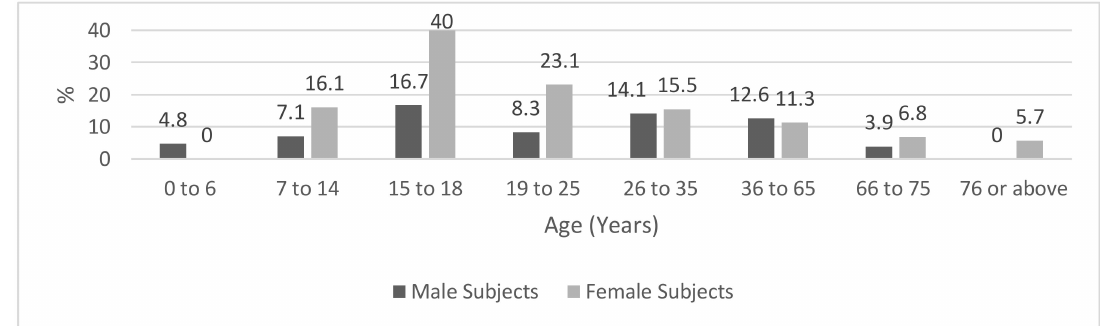
Figure 3. Prevalence (%) of positive IgG tests according to age group and